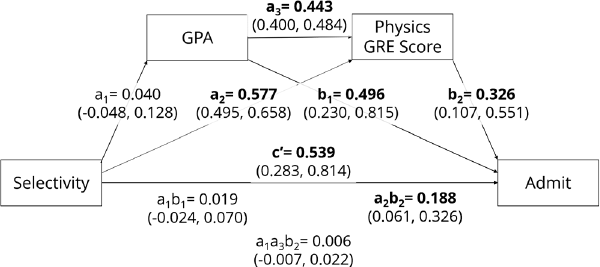
FIG. 10. Visual representation of the bootstrapped coefficients in Eqs. (5) to (7). We do find evidence of the physics GRE score mediating selectivity and admissions status but do not find evidence of GPA mediating selectivity and admissions status. We do not find evidence of a serial mediating relationship. Statistically significant coefficients are in